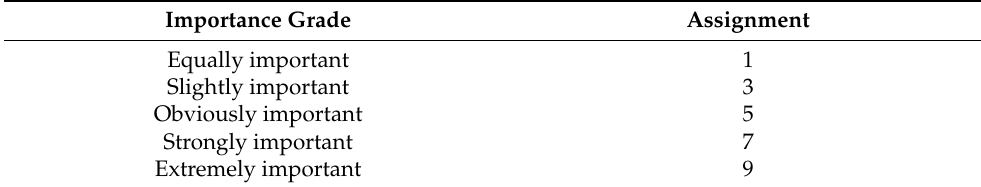
Table 4. Importance grade and its assignment